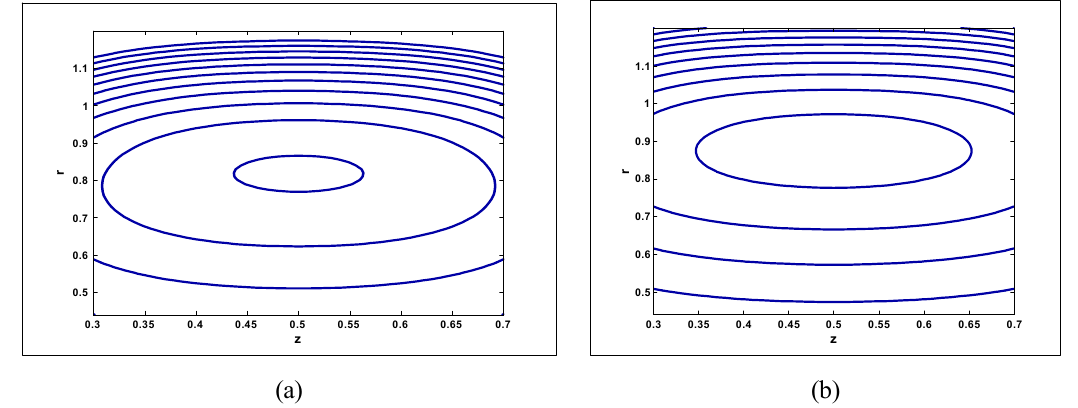
Figure 18. Streamlines for two di ff erent values of r 1 for ( a ) r 1 = 1.11 and ( b ) r 1 = 1.13. The other parameters are chosen as M = 0.2, Q = 0.4, ϕ = 0.1 when µ = 1 ,2.0